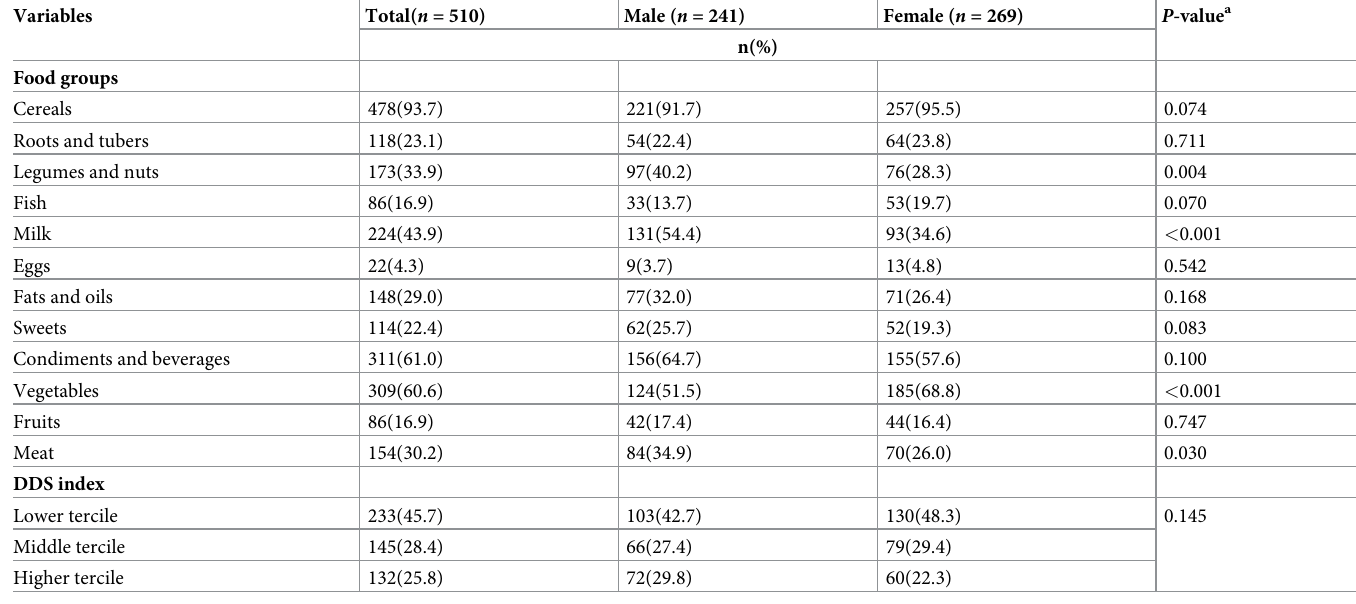
Table 2. Dietary diversity and consumption of food groups between genders of the participants in Monduli District, Tanzania.